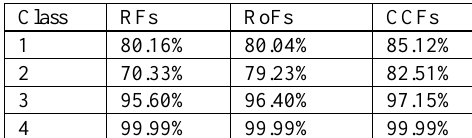
Table 5. Classification accuracies of RoFs and CCFs when compared to RF for all Pays of Brest (S1 + S2).